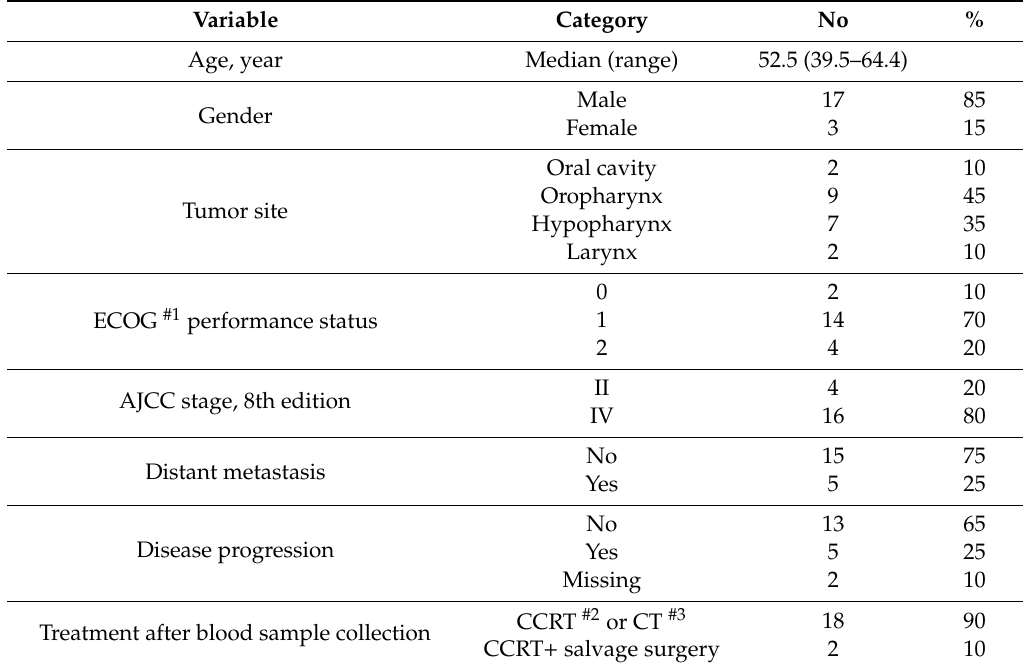
Table 1. Patients’ demographic data.